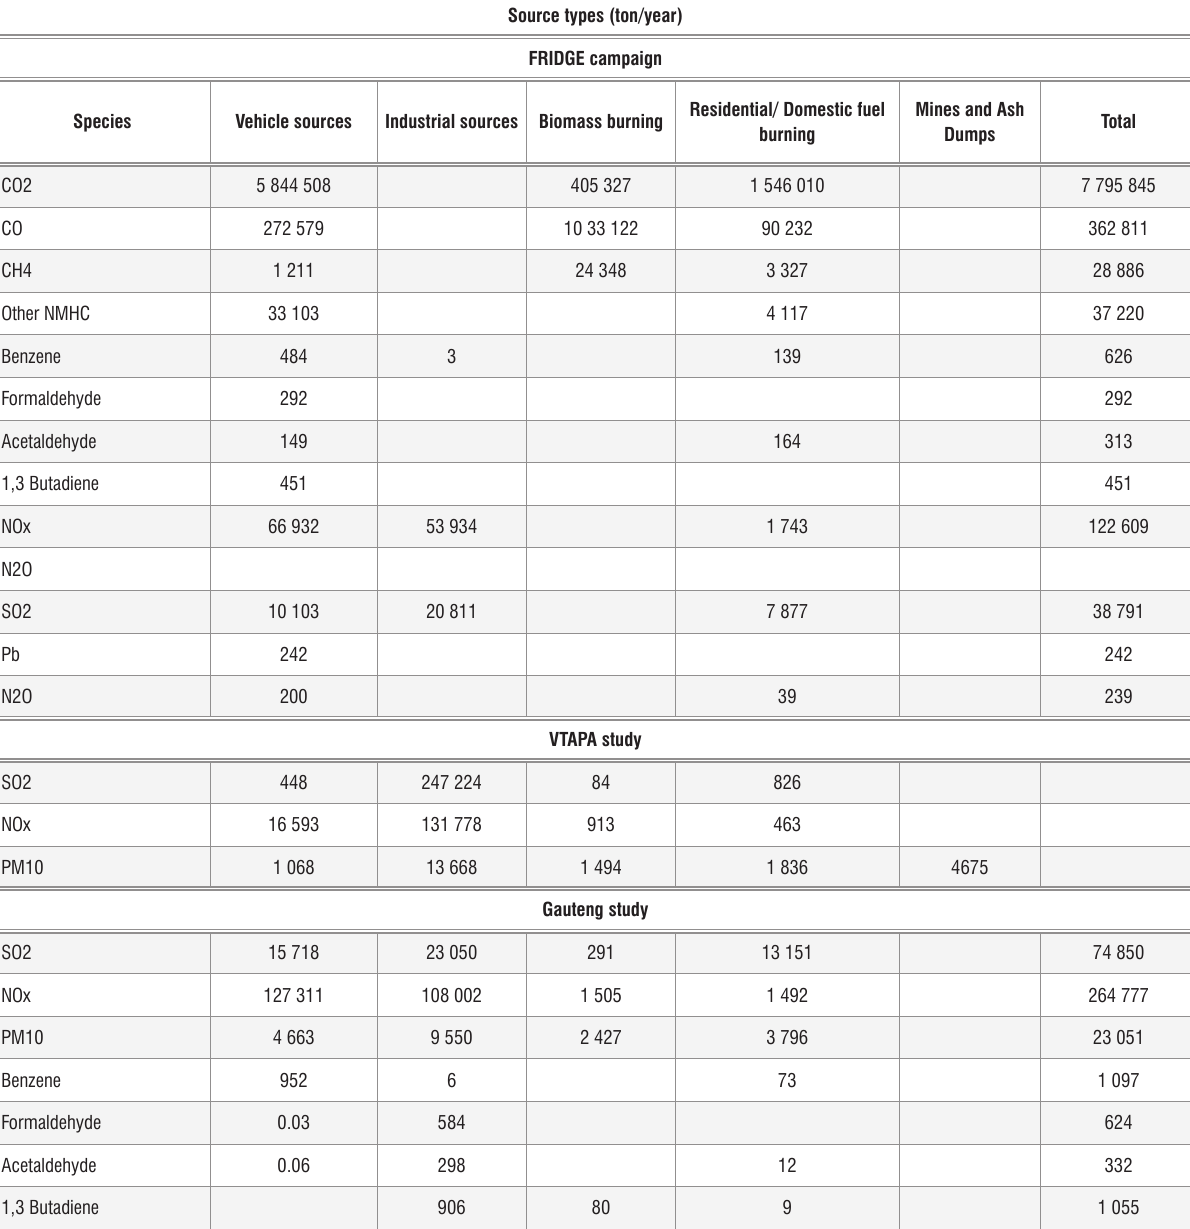
Emission sources (ton/year) for the Johannesburg-Pretoria megacity based on the Fund for the Research into Industrial Development Growth and Equity (FRIDGE) 21 emission inventory. The Vaal Triangle Airshed Pollution Area (VTAPA) 22 and Gauteng 23 studies are also included as supplementary data. It must also be noted that the use of Pb as an additive in petrol has been phased out since the FRIDGE emission inventory was